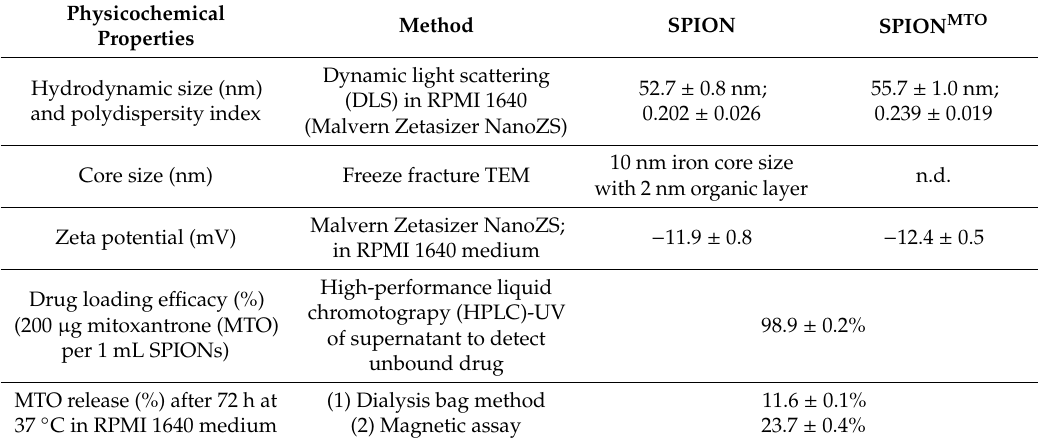
Table 1. Physicochemical properties of superparamagnetic iron oxide nanoparticles (SPION) and mitoxantrone-loaded ones (SPION MTO ) adapted from [28,29], Elsevier, 2018,